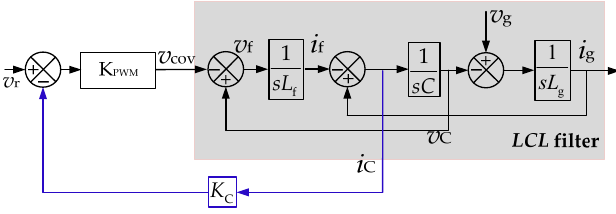
Figure 8. Block diagram of voltage source converter (VSC) with an LCL-type filter.